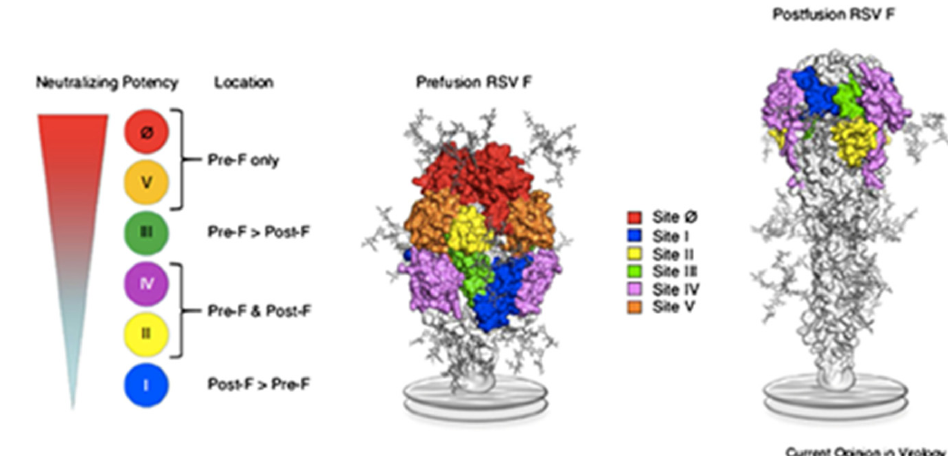
Figure 1. Locations of 6 antigenic sites on the prefusion ( left ) and postfusion ( right ) structures of RSV F glycoprotein and their neutralizing potencies. Reprinted by permission from Springer Nature. Clin Microbiol & Infect Dis. Human respiratory syncytial virus: pathogenesis, immune responses, and current vaccine approaches. Taleb, et al., 2018 [11]. copyright permission from